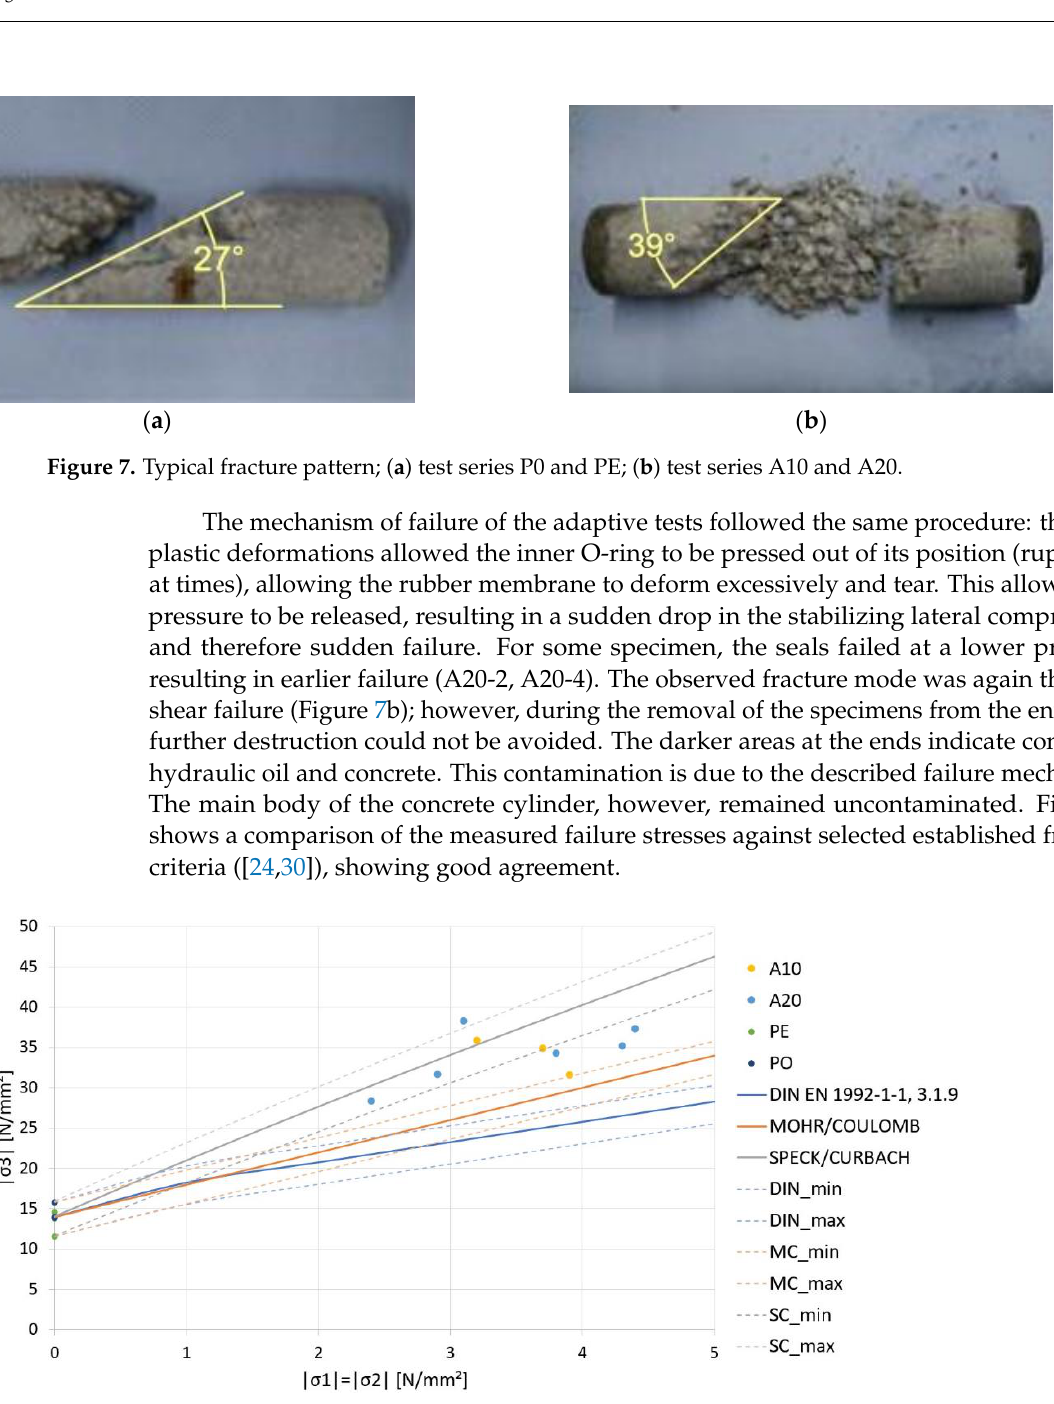
Figure 8. Comparison of the measured increase in fracture stress σ3 vs. different fracture criteria [24,30] based on the measured uniaxial fracture stress |σ1|=|σ2|.